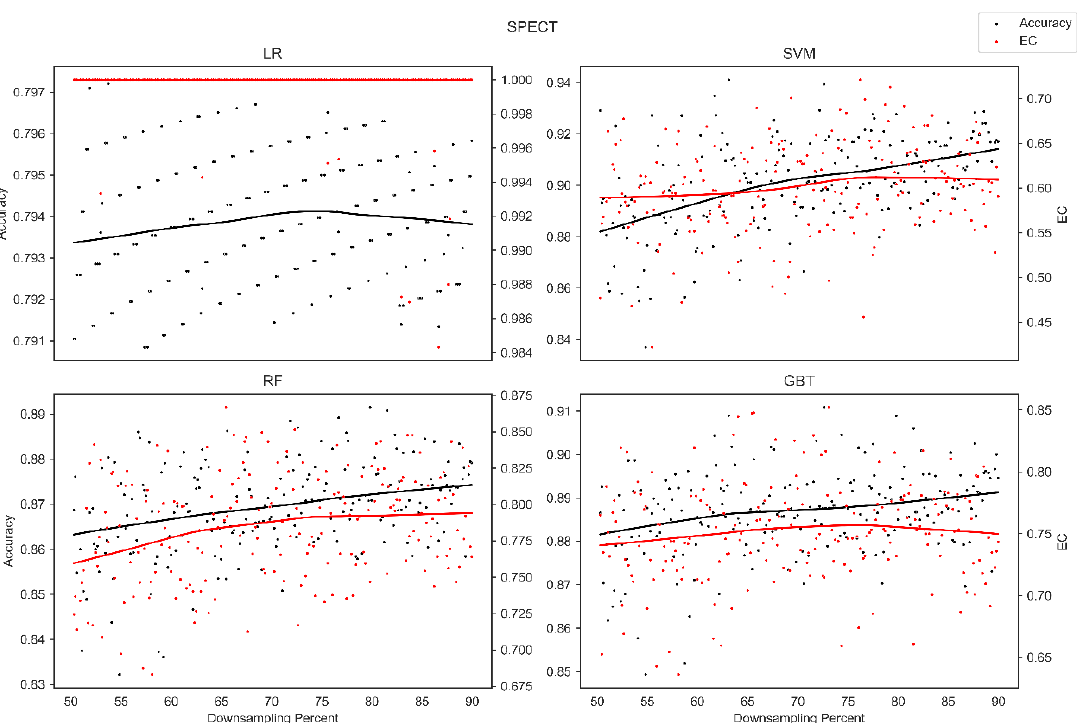
Figure 7. Average error consistency and overall accuracy vs. varying sample size percentages (down-sampled) from the Parkinsons dataset. Trend lines were established with locally weighted regression and smoothing [25].